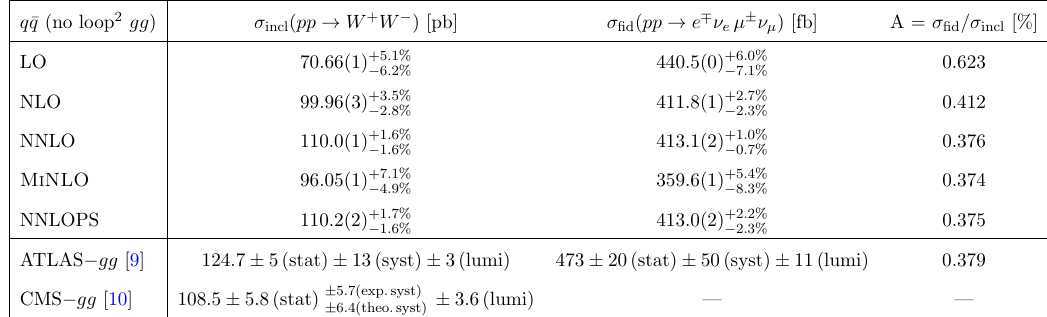
(cid:22) (cid:6) (cid:23) production with (cid:12)ducial e (cid:22) ), while excluding the loop-induced gg con- s